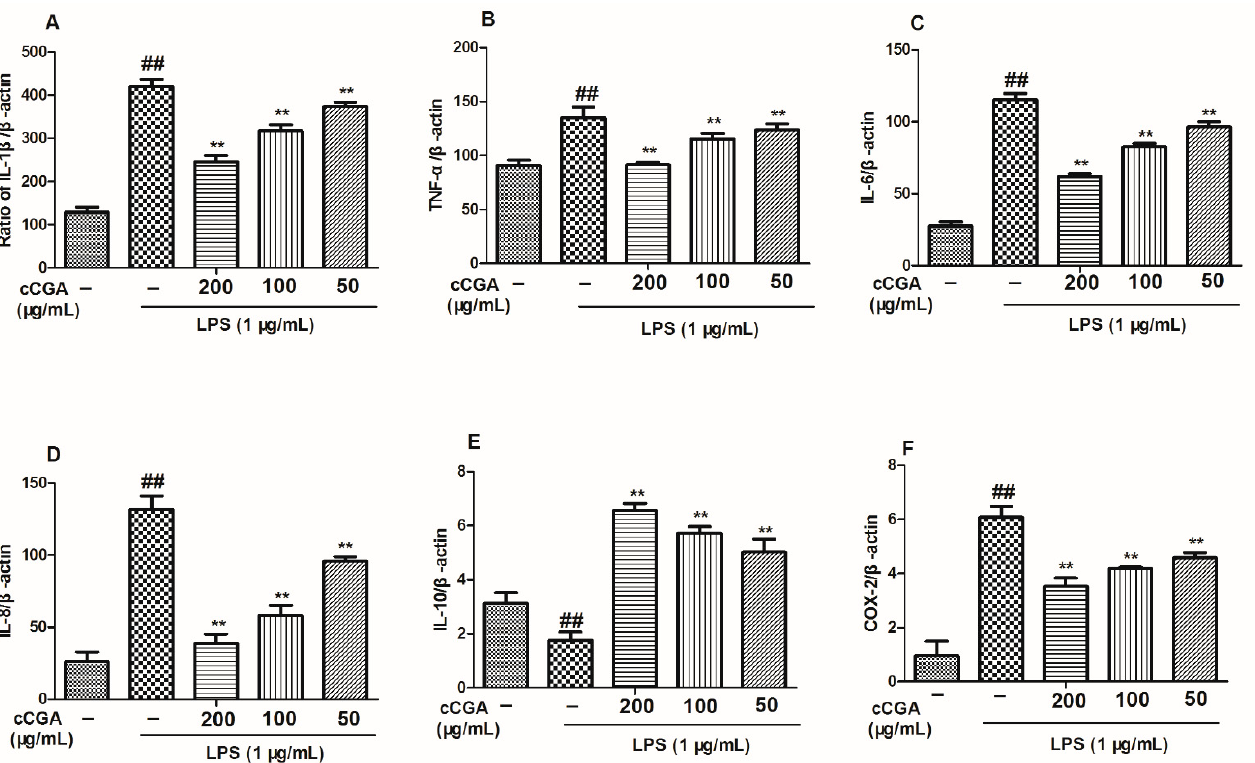
Figure 7. Effects of CCGA from A. adenophora on mRNA level of inflammatory-related cytokines in LPS-induced RAW264.7 cells. ( A – E ) mRNA level of inflammatory-related cytokines; ( F ) mRNA level of COX-2. Notes: ## p < 0.01 vs. blank control group, ** p < 0.01 vs. LPS, n = 3 (mean ± standard deviation).